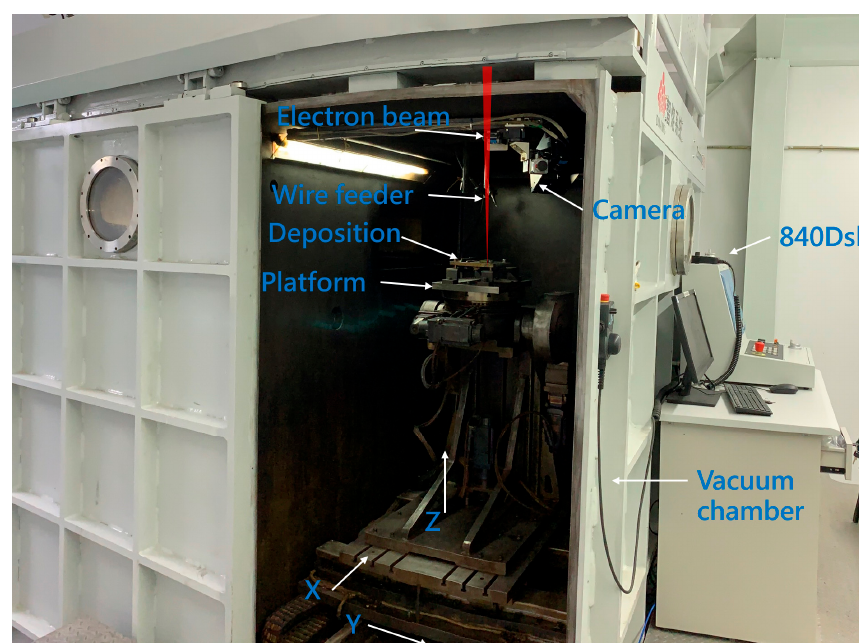
Figure 9. Physical system for the closed-loop control Figure 7. Physical system for the closed-loop control experiment.